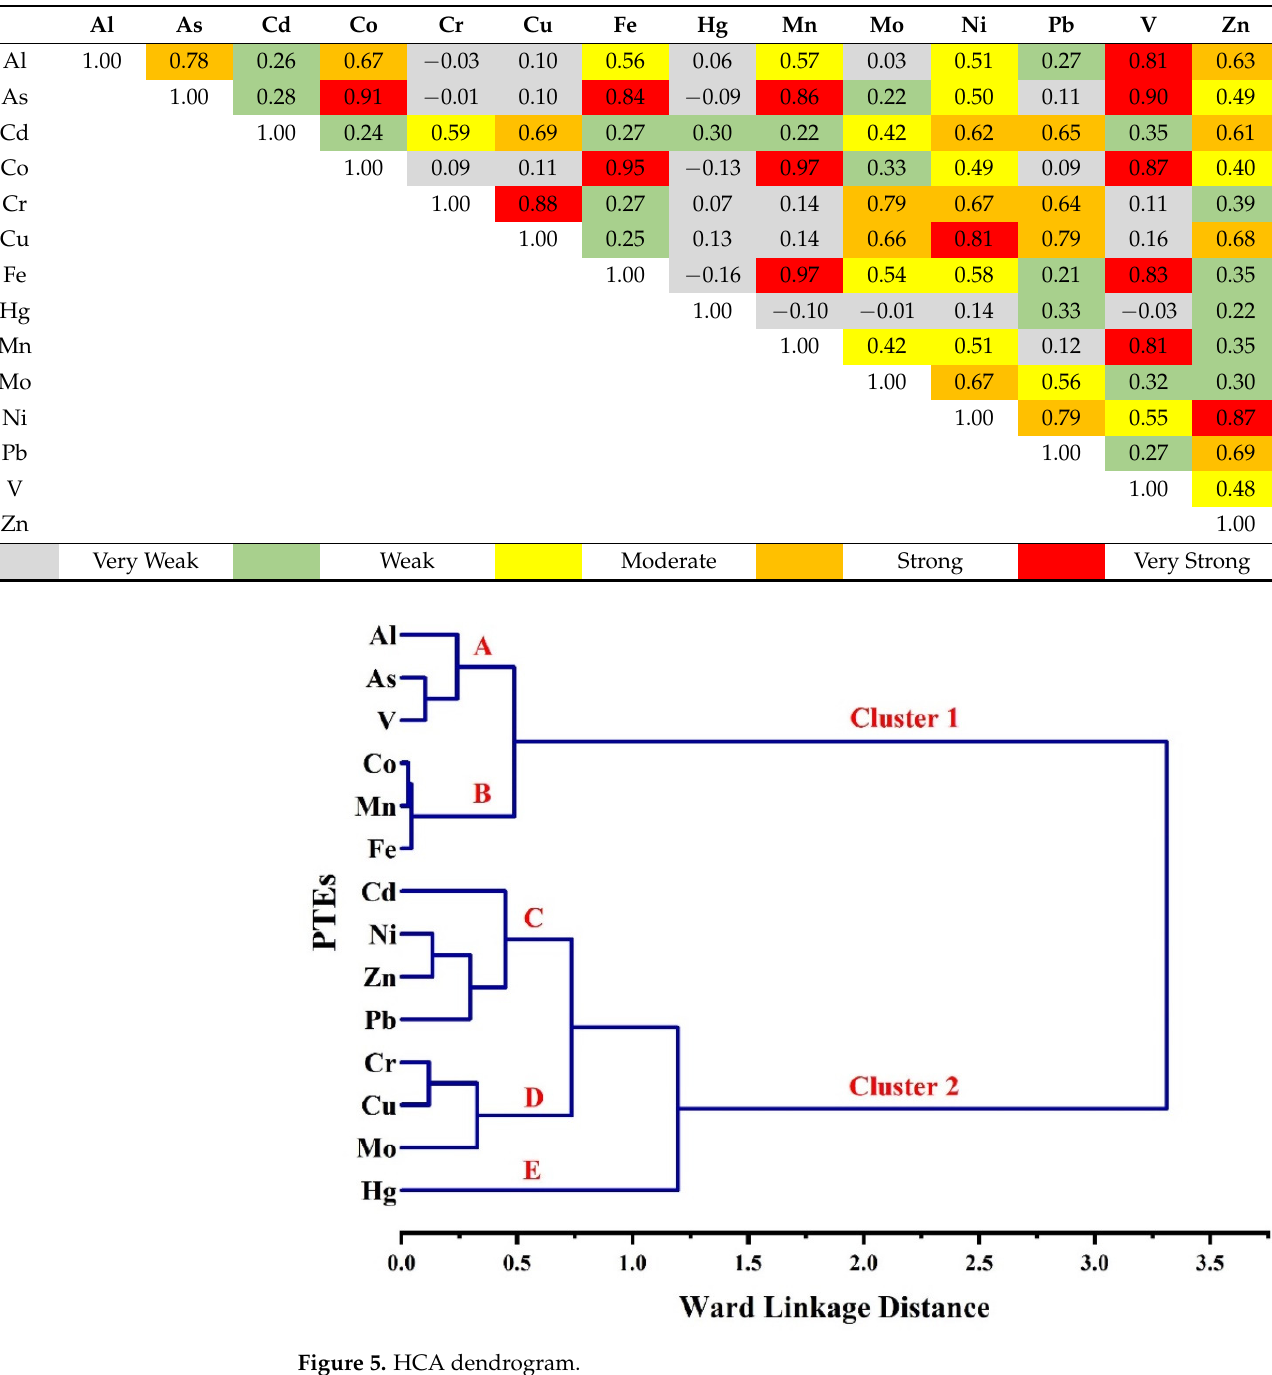
Table 4. PCC matrix for PTEs in the investigated household dust ( n = 38).